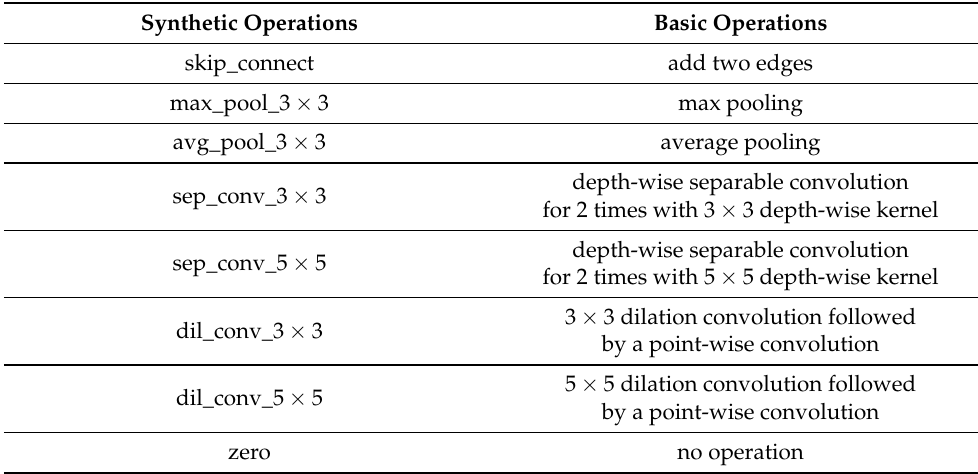
Table 1. Synthetic